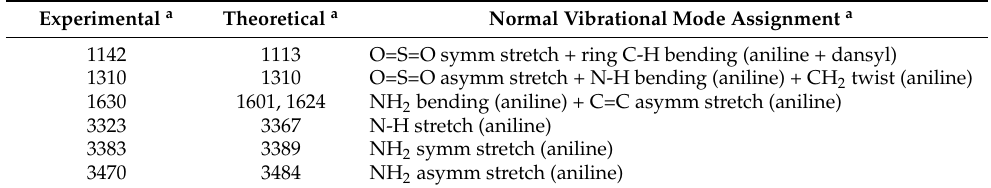
Table 4. Experimental and theoretical vibrational frequencies (cm − 1 ) of